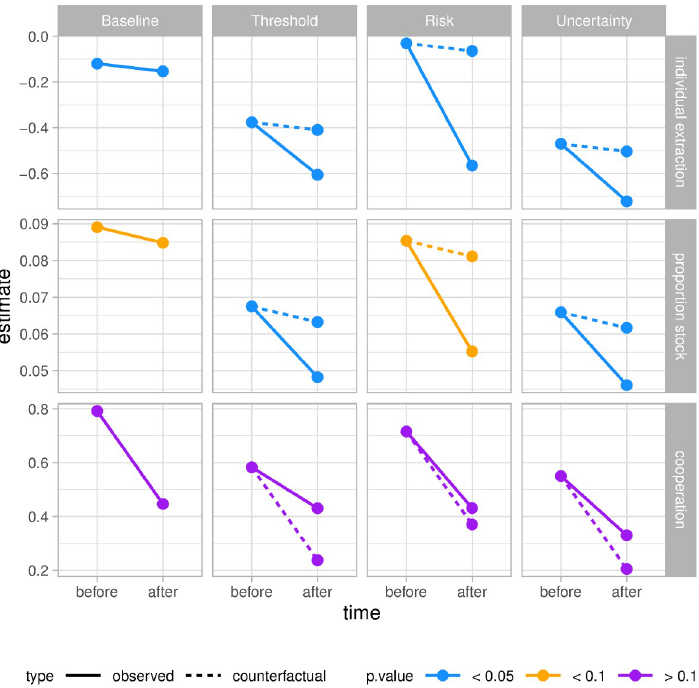
Fig 3. Relationships between response variables of individual behaviour. Figure A) shows the relationship between cooperation and coordination, figure B) shows the relationship of mean extraction and the mean proportion of the extraction. Each point represent an individual player (N = 256) and the summary statistic calculated over the second part of the game (rounds 7-16, N = 2560).